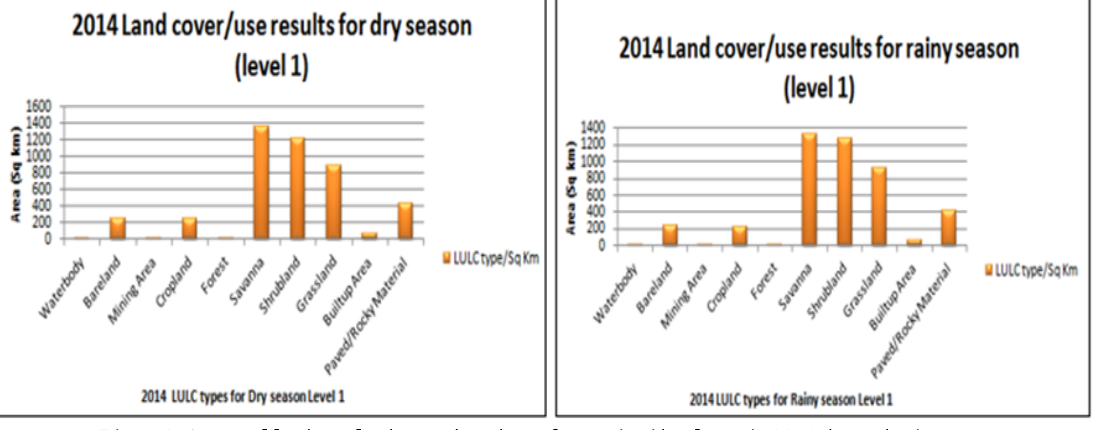
Figure 3: Seasonal land use-land cover bar charts for semi-arid Palapye in 2014 dry and rainy season.